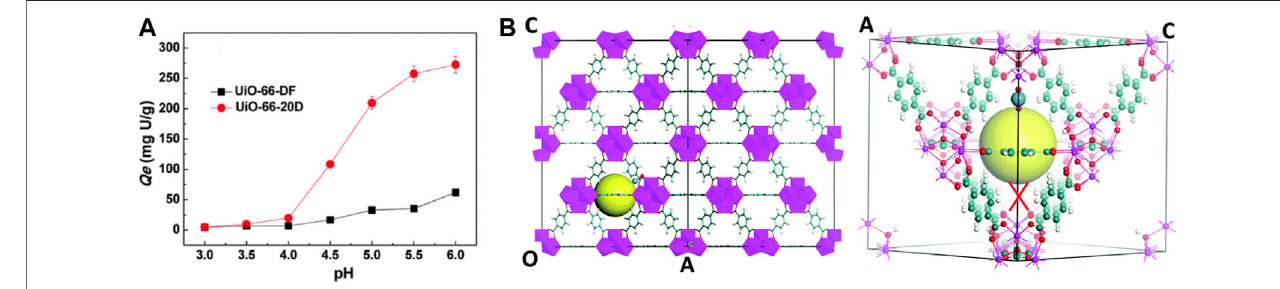
Frontiers in Chemistry |